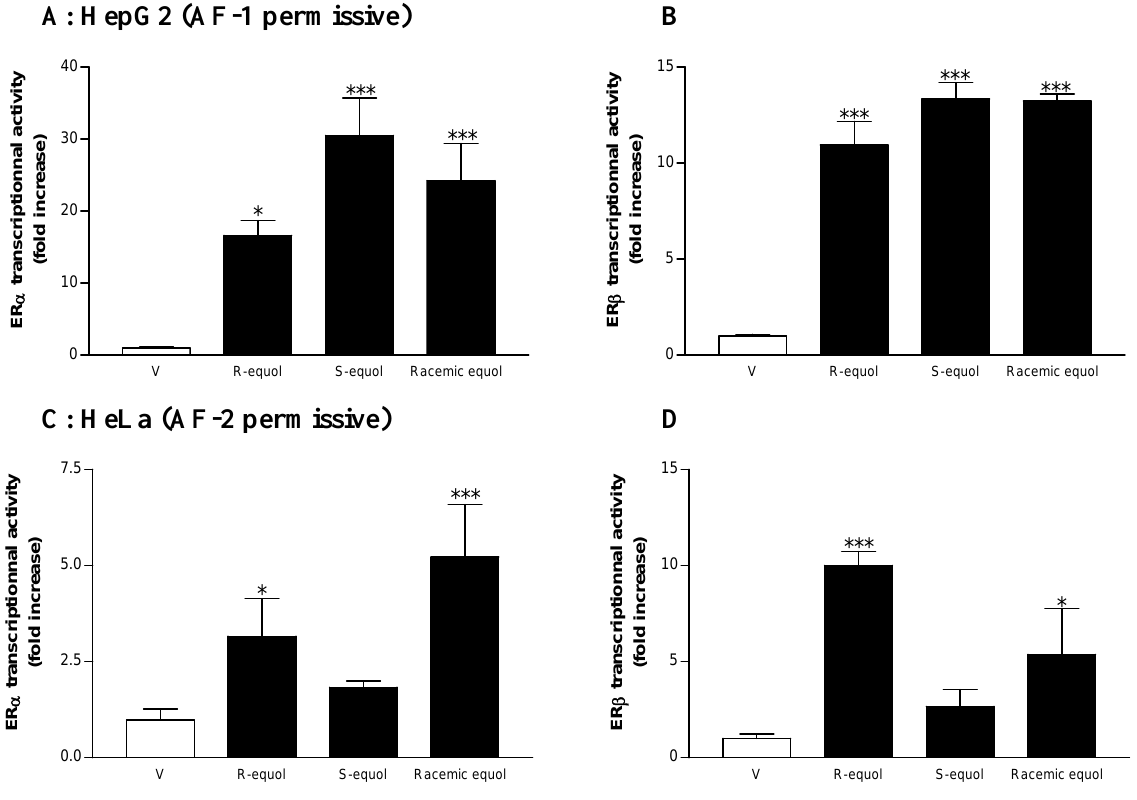
Figure 3. Transcriptional activation of ER by enantiomeric forms of equol in HepG2 (AF- 1 permissive) and HeLa (AF-2 permissive) epithelial cells. The effects of control (Vehicle (V), EtOH 0.01%), R- and S- forms and racemic equol (10 µM) on ER  ( A, C ) and ER  ( B, D ) transcriptional activities in HepG2 and HeLa cell lines, respectively. Cells were co- transfected with ER  or ER  and the ERE-TK-LUC. Data are expressed as reporter fold induction compared to control. Shown are means ± SEM of 2–5 independent experiments, each performed in triplicate. Comparisons between experimental conditions are described in “Experimental section”. Statistical significances are indicated by * or *** for comparison to control for p < 0.05 or p < 0.001,